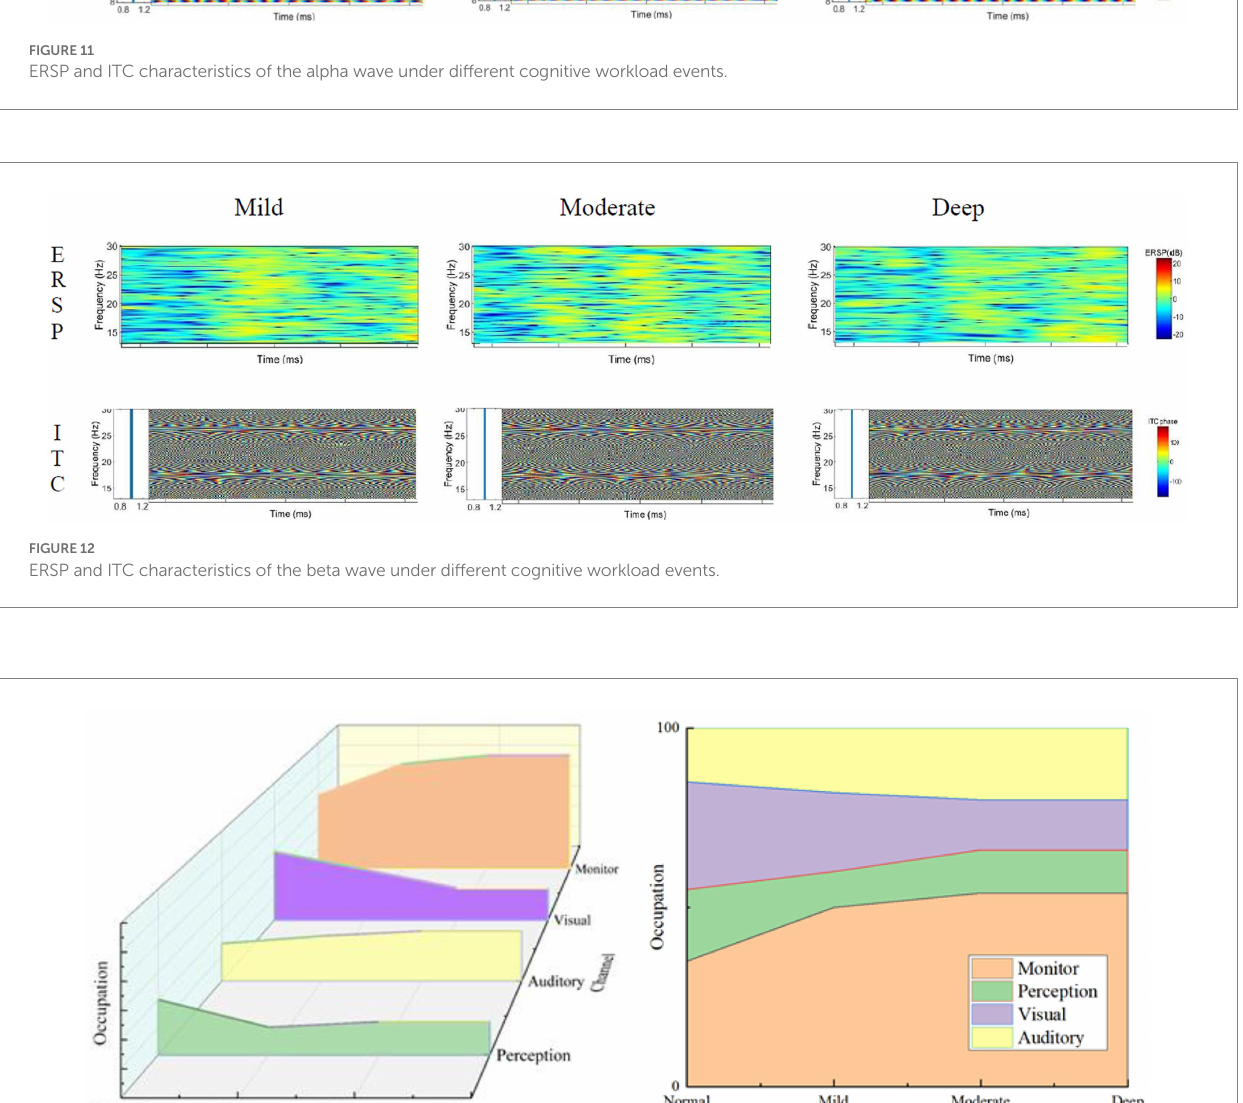
reduction of visual channel resources means that the attention to the external environment is showing a downward trend, but the auditory channel takes up more resources and requires more energy for memory processing. The perception channel resource is also gradually